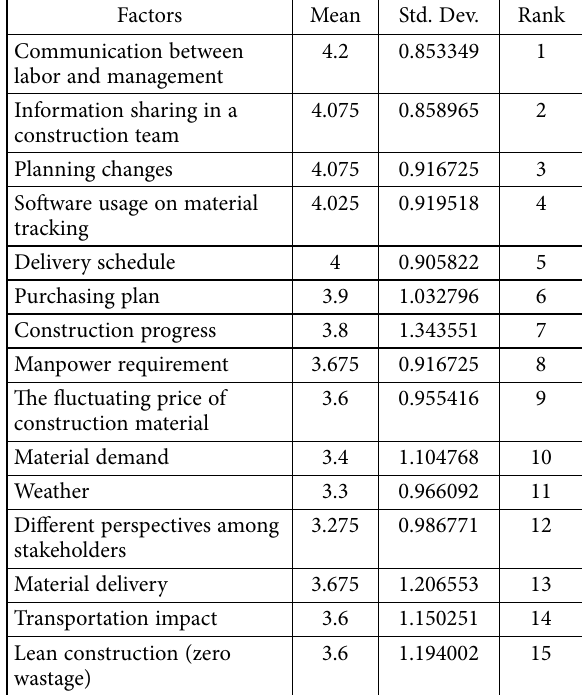
Table 2. Ranking of factors